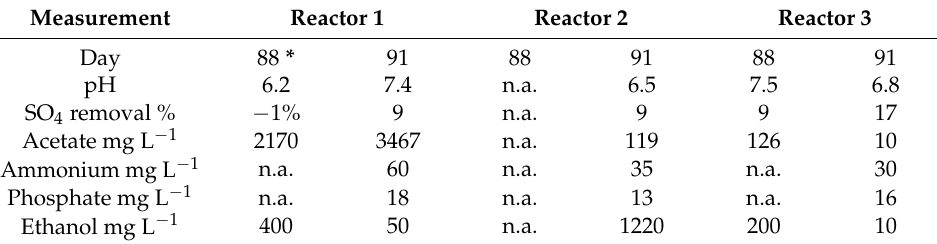
Table 2. Physicochemical parameters of the effluents on day 91.